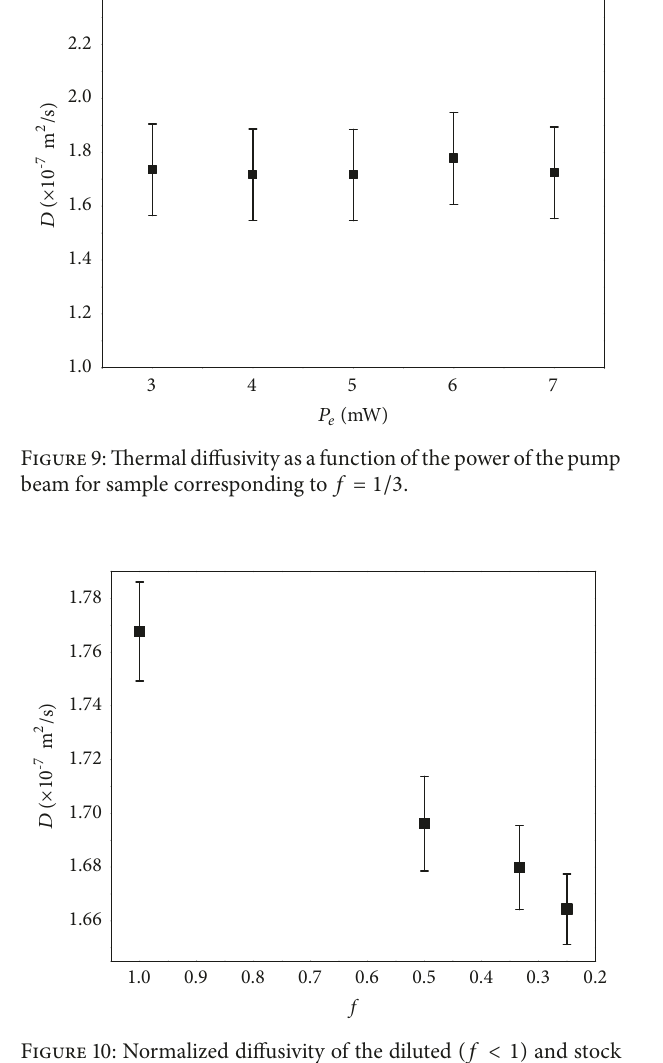
least for this power range, showing that no other diffusive process is concomitant with the thermal diffusion